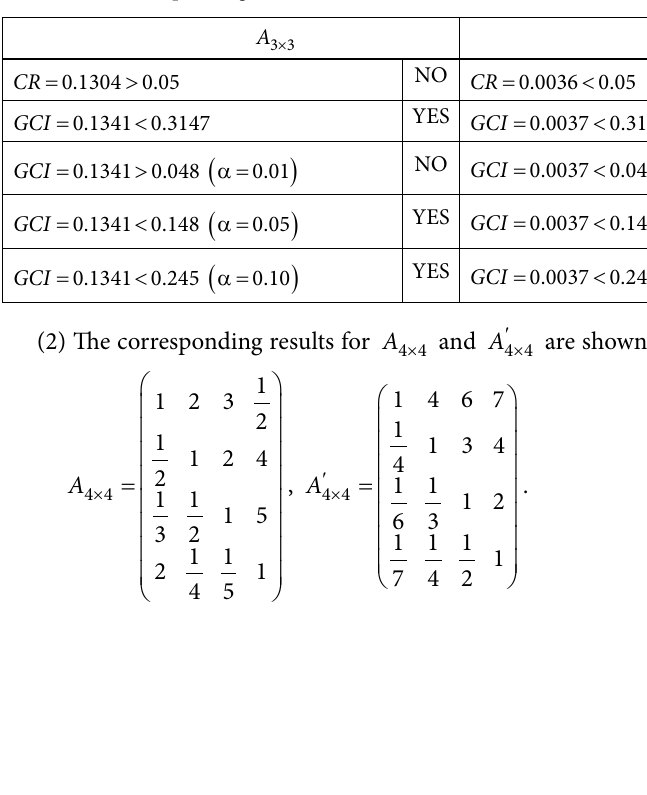
Table 4. The corresponding results for two 3-order PCMs